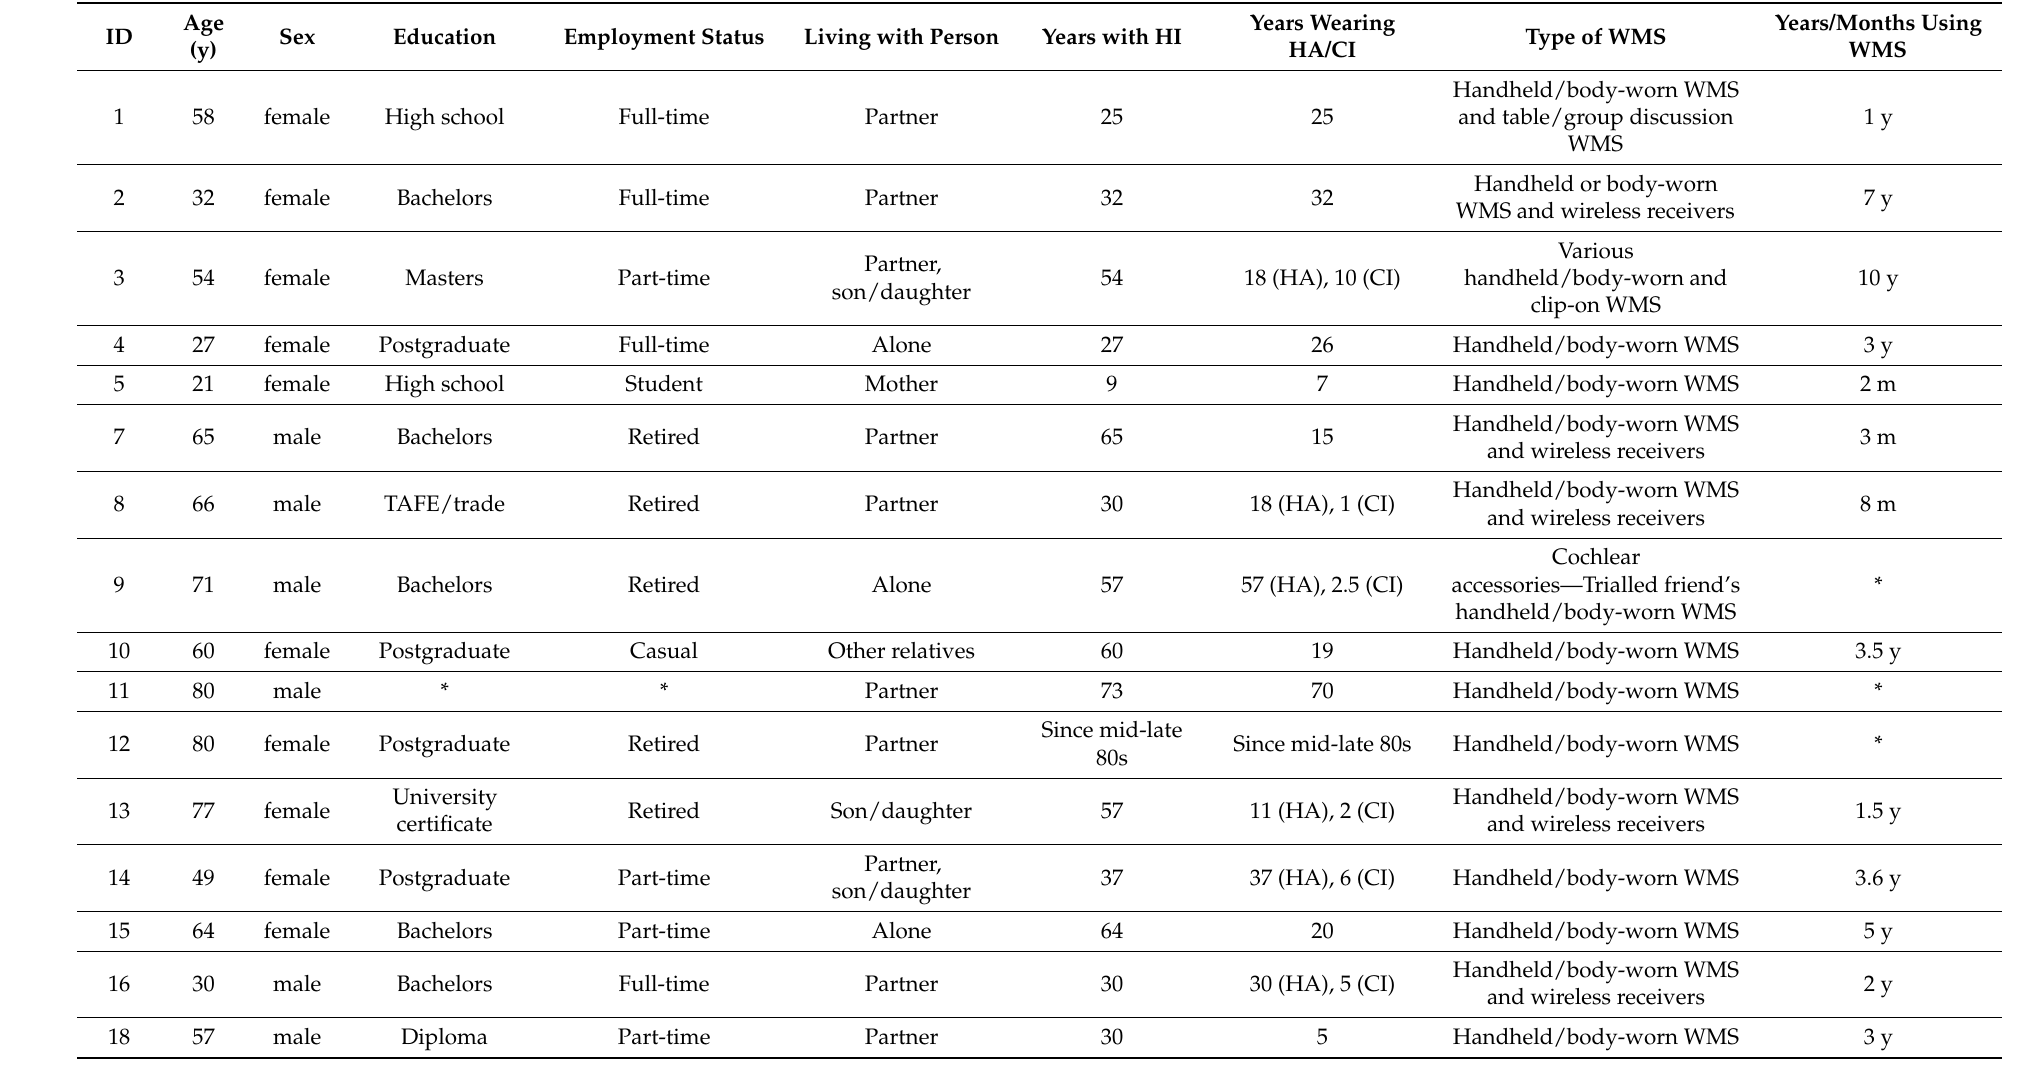
Table 1. Demographic Characteristics of Clients (n =